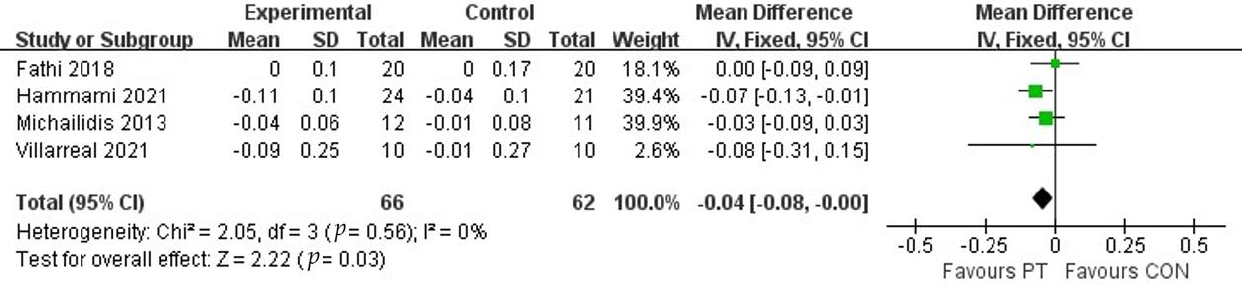
Figure 7. Forest plot of 10-m sprint of experimental and control groups.